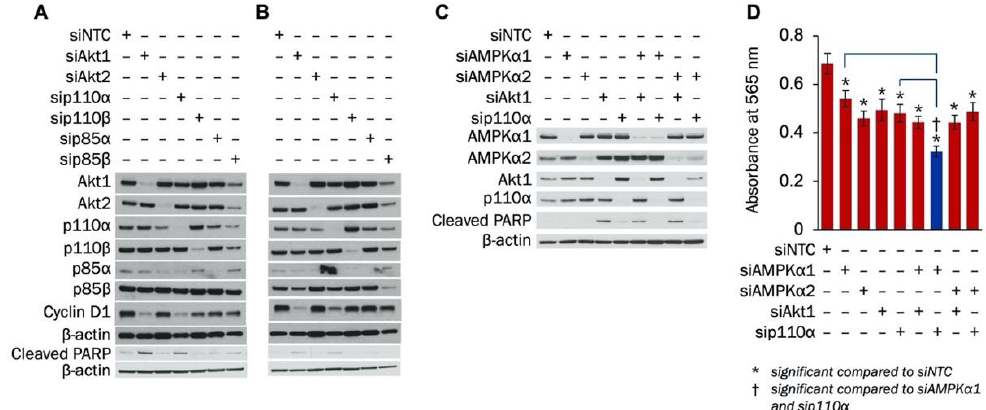
Figure 3. Knockdown of Akt1 or p110 α increases apoptosis and decreases proliferation in MDA-MB-231 cells. MDA-MB-231 cells were transfected with 100 nM of siRNA to Akt1, Akt2, p110 α , p110 β , p85 α , or p85 β . Expression of Akt1, Akt2, p110 α , p110 β , p85 α , p85 β , cyclin D1, and cleaved PARP was determined with Western blot ( A ) 72 h and ( B ) 96 h after transfection. ( C ) MDA-MB-231 cells were transfected with siRNA to AMPK α 1, AMPK α 2, Akt1, or p110 α alone or in combinations. Transfection concentrations were (1) individual siRNA: 50 nM, (2) combination siRNA: 50 nM each (100 nM total), and (3) siNTC: 100 nM. Expression of AMPK α 1, AMPK α 2, Akt1, p110 α , and cleaved PARP was determined with Western blot 72 h after transfection. ( D ) MDA-MB-231 cells were transfected with siRNA to AMPK α 1, AMPK α 2, Akt1, or p110 α alone or in combinations. Transfection concentrations were (1) individual siRNA: 50 nM, (2) combination siRNA: 50 nM each (100 nM total), and (3) siNTC: 100 nM. Cells were plated at a density of 3000 cells / well 48 h after transfection. SRB growth assay was performed 48 h after plating ( n = 12). *indicates p -value < 0.0001; NTC, Non-targeting control was used as a negative control.